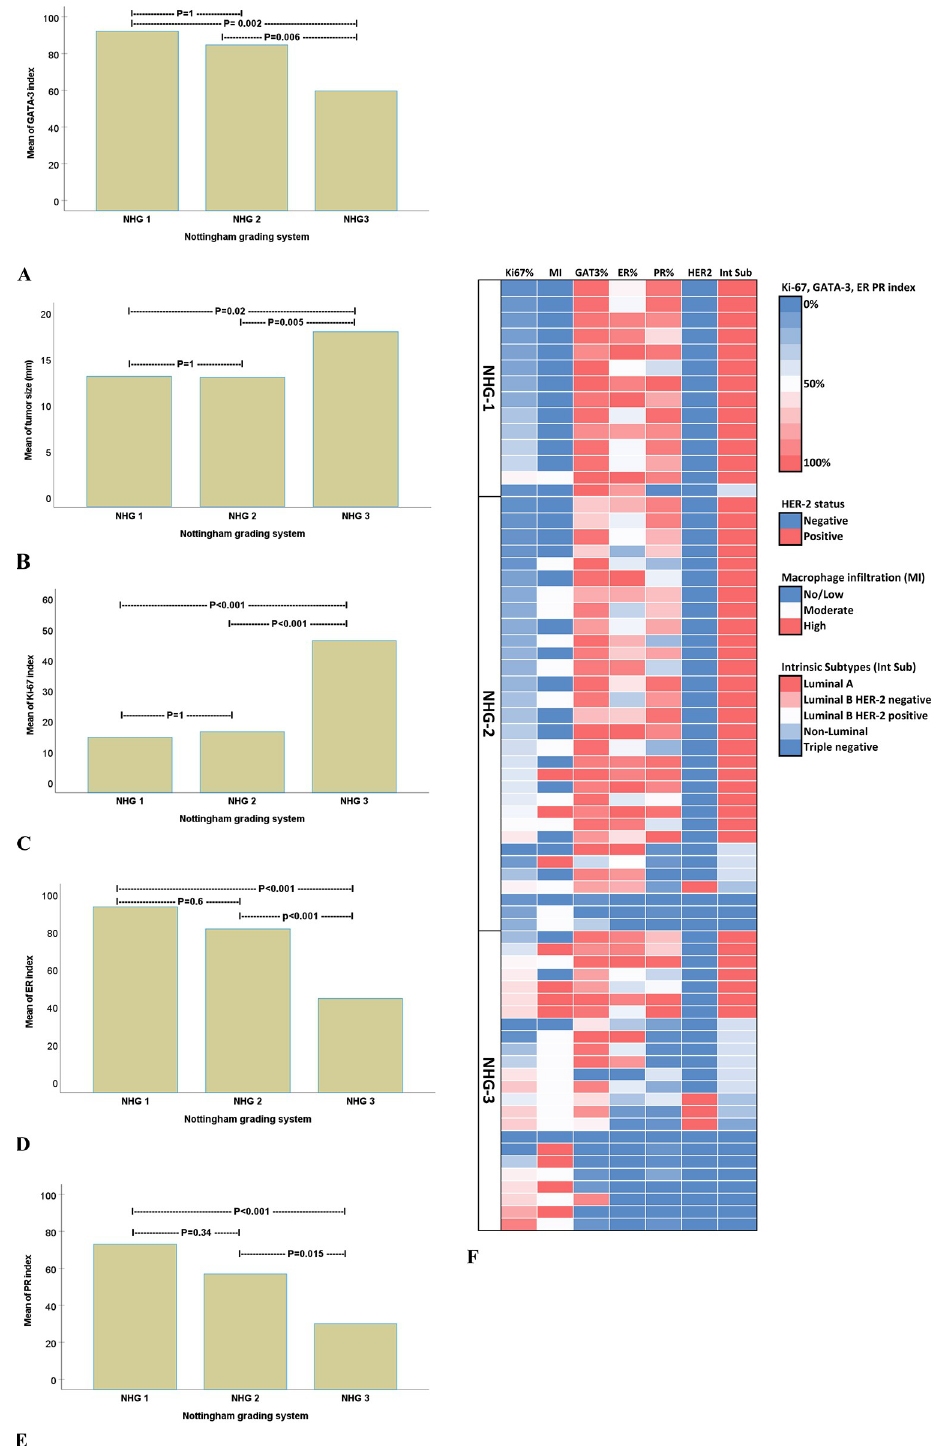
Fig 3. ANOVA analysis followed by Bonferroni’s post hoc test comparing breast cancer Nottingham Histologic Grade (NHG) in relation to (A) GATA-3 index, (B) tumor size, (C) Ki-67 index, (D) ER index and (E) PR index. (F) Heat map of breast cancer NHG visualizes how segregated the distribution of macrophage infiltration, intrinsic subtypes, HER2 status, GATA3, ER, and PR indexes are between the NHG1, NHG2, and NHG3 tumors, respectively.